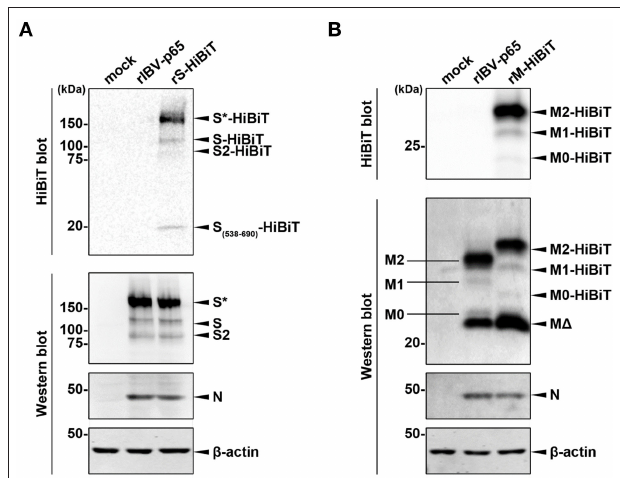
FIGURE 2 | Determining the expression of HiBiT-tagged proteins. (A) Determination of S-HiBiT expression in Vero cells infected with rS-HiBiT. Vero cells were infected with rIBV-p65 or rS-HiBiT at MOI ∼ 2, or incubated with mock lysate for 18h. Protein samples were resolved by SDS-PAGE and subjected to HiBiT blot and Western blot using antisera against IBV S2 and N. Beta-actin was used as the loading control. Sizes of the protein ladders in kDa were indicated on the left. The experiment was repeated three times with similar results, and the result of one representative experiment is shown. S*, glycosylated S protein. (B) Determination of M-HiBiT expression in Vero cells infected with rM-HiBiT. Vero cells were infected with rIBV-p65 or rM-HiBiT at MOI ∼ 2, or incubated with mock lysate for 24h. Protein samples were resolved by SDS-PAGE and subjected to HiBiT blot as in (A) . Western blot was performed using antisera against IBV M and N. Beta-actin was used as the loading control. Sizes of the protein ladders in kDa were indicated on the left. The experiment was repeated three times with similar results, and the result of one representative experiment is shown. M0, unglycosylated M protein; M1, singly glycosylated M protein; M2, dual glycosylated M protein; M 1 , a putative cleavage product of M